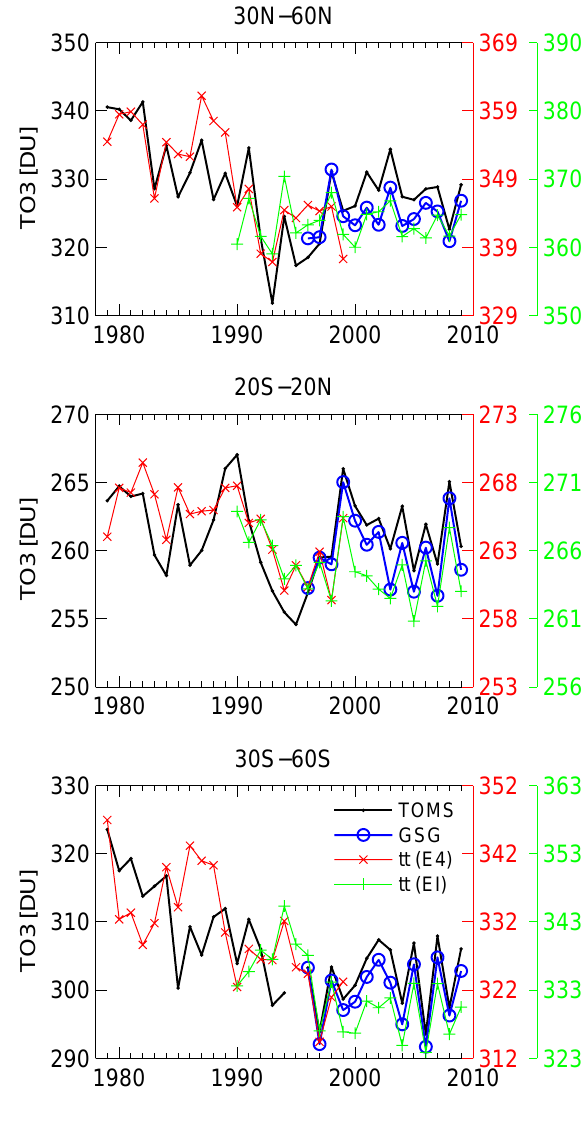
Fig. 1. Total ozone (TO3) annual means from the tt (time-dependent chemistry) model run, as compared to the TOMS/SBUV merged TO3 dataset (“TOMS”) and the GOME/SCIAMACHY/GOME2 merged datasets (“GSG”). Model runs are performed in two periods, 1979–1999 using ERA-40 data (red × ), and 1990–2009 using ERA-Interim (green + ). Modelled TO3 shows different offsets to satellite observations during the two periods, which are accounted for by the shifted right-hand axes (middle axis 1979–1999, far right axis 1990–2009). The climatological ozone column below 330K has been added to modelled